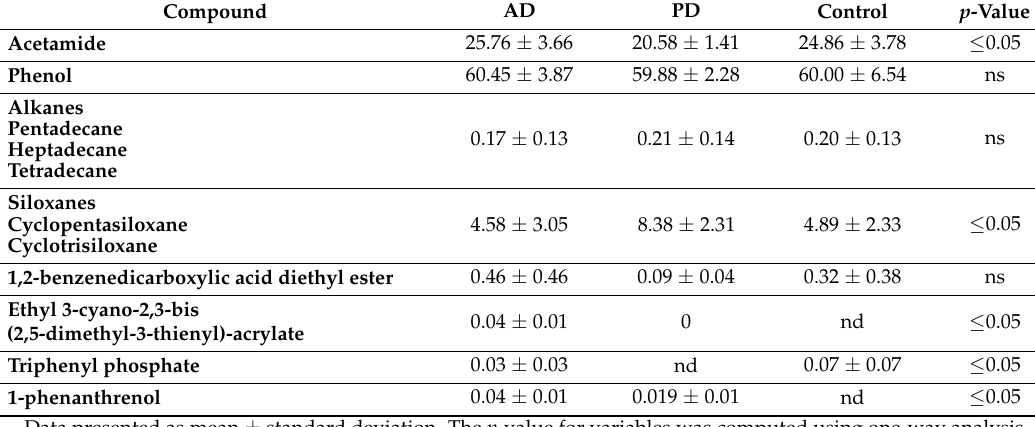
Data presented as mean ± standard deviation. The p -value for variables was computed using one-way analysis of variance (ANOVA). p ≤ 0.05; ns = not significant; nd = not determined; AD, Alzheimer’s disease; PD, Parkinson’s